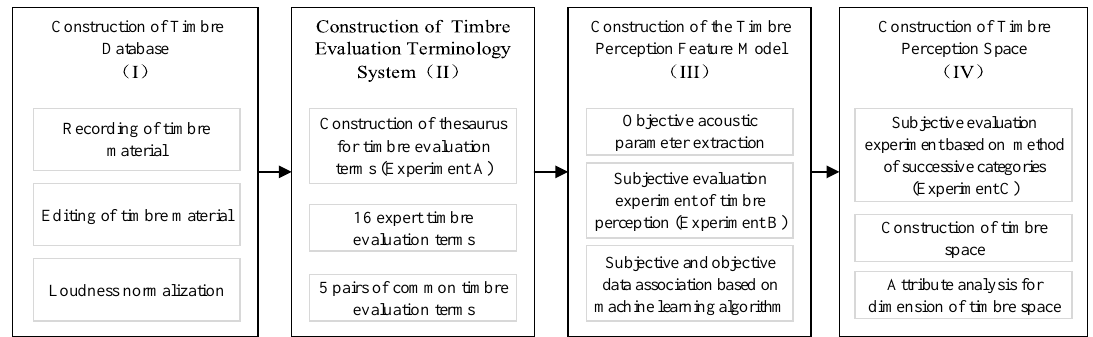
Figure 1. The proposed methodology.